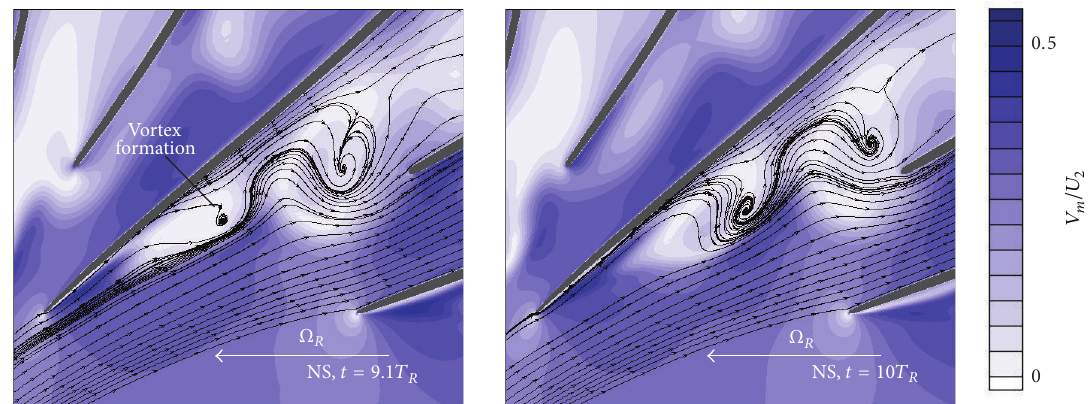
Figure 9: Instantaneous reduced meridional velocity contours and streamlines at 90% span in the inducer.